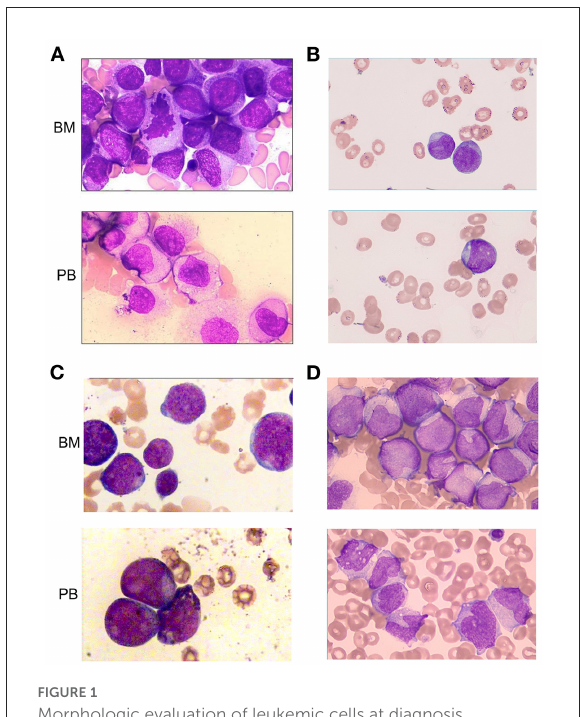
FIGURE1 Morphologic evaluation of leukemic cells at diagnosis (Wright–Giemsa stain, × 1,000). (A–D) represent cases 1, 2, 3, and 4, respectively. BM, bone marrow; PB, peripheral blood.